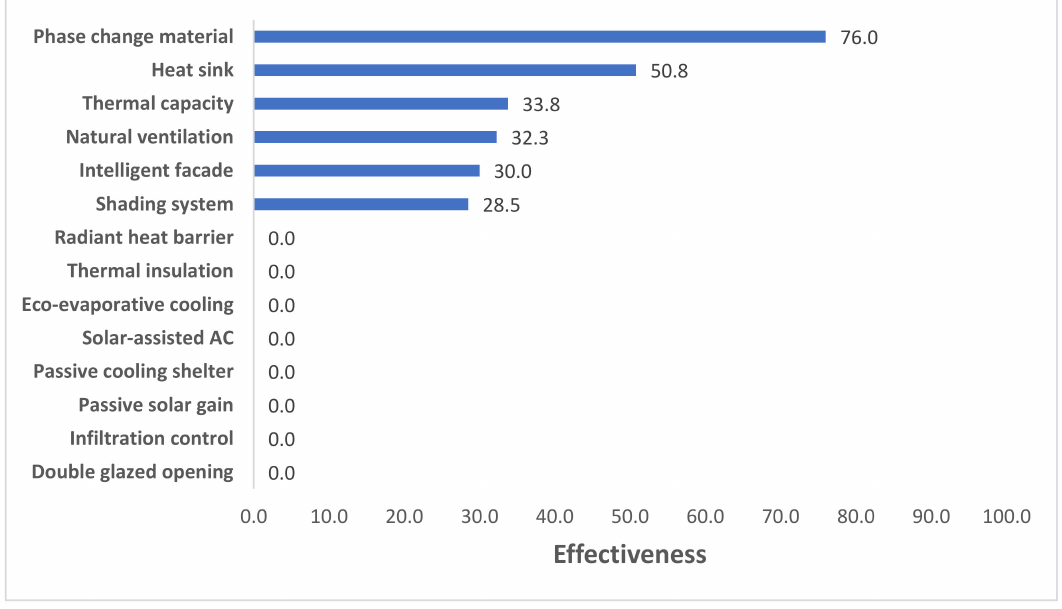
Figure 6. E ff ectiveness of the passive methods for a comfort temperature of 22 ◦